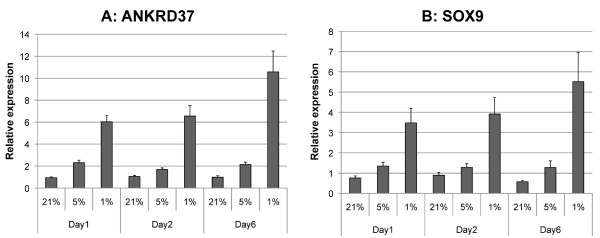
Expression of ANKRD37 (A) SOX9 (B). Relative mean expression is presented on day 1, 2, and 6 in human chondrocytes cultured in 21%, 5% or 1% oxygen (error bars: SEM). RPL13A and B2M are used as reference genes. Values for each sample are normalized to baseline expression.